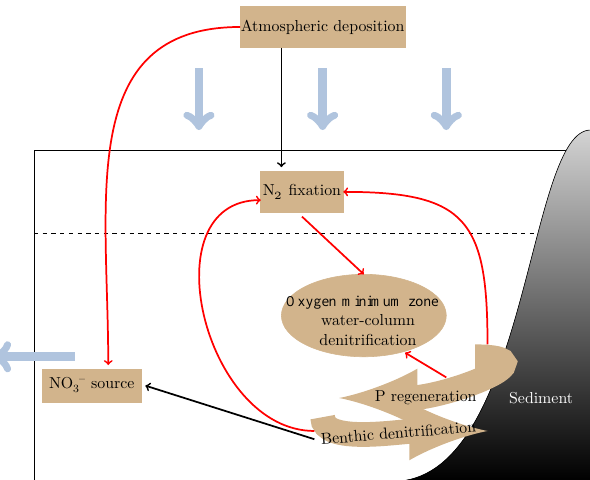
Figure 8. Schematic of the model sensitivity to different processes related to the nitrogen budget of the ETSP. The red solid lines repre- sent stimulatory effects, and the black solid lines represent depres- sive